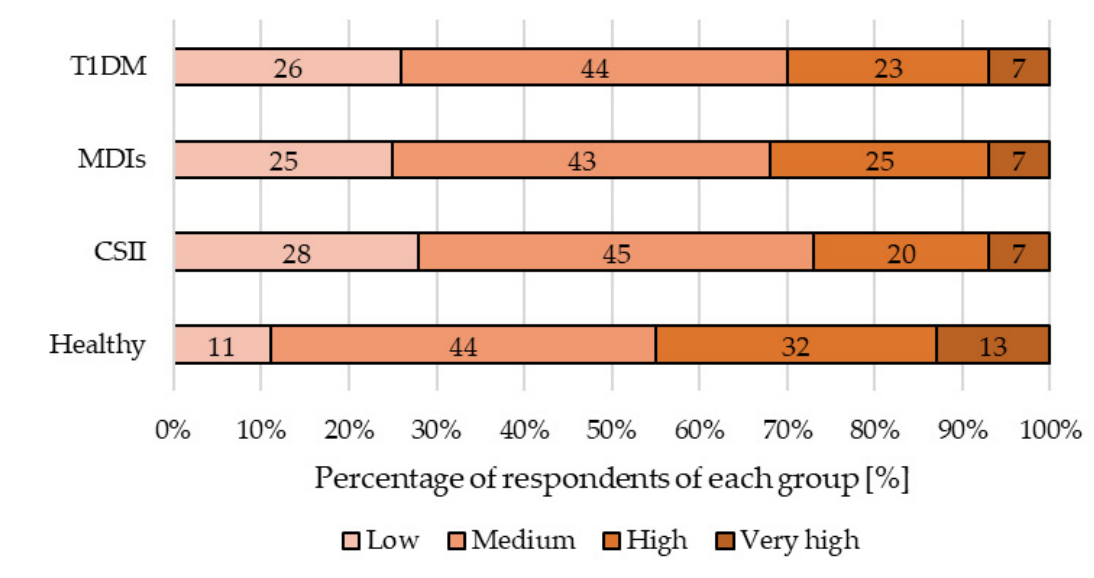
Figure 2. Stress level distribution of study cohort during the second wave of the COVID-19 pandemic. Abbreviations: continuous subcutaneous insulin infusion (CSII), multiple daily injections (MDIs), type 1 diabetes mellitus (T1DM). Statistically significant ( p < 0.001) dependence between T1DM and healthy (the Chi-square